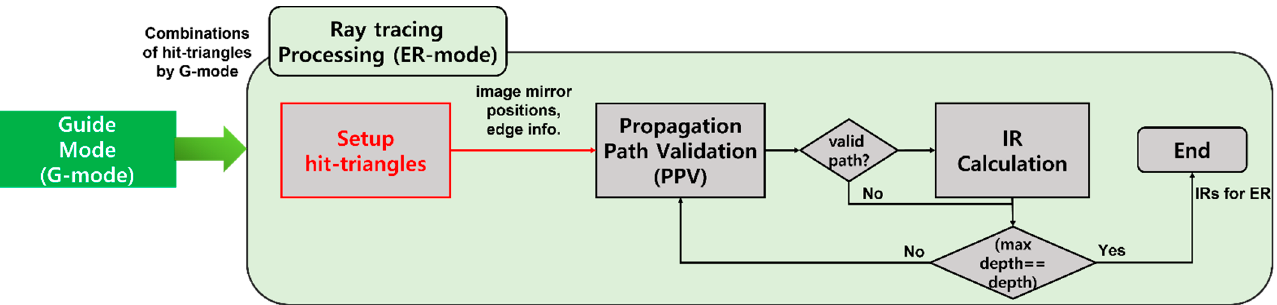
Figure 8. Flowchart of ER mode for one sound source modified to suit the multi-threaded method: new step (red box).